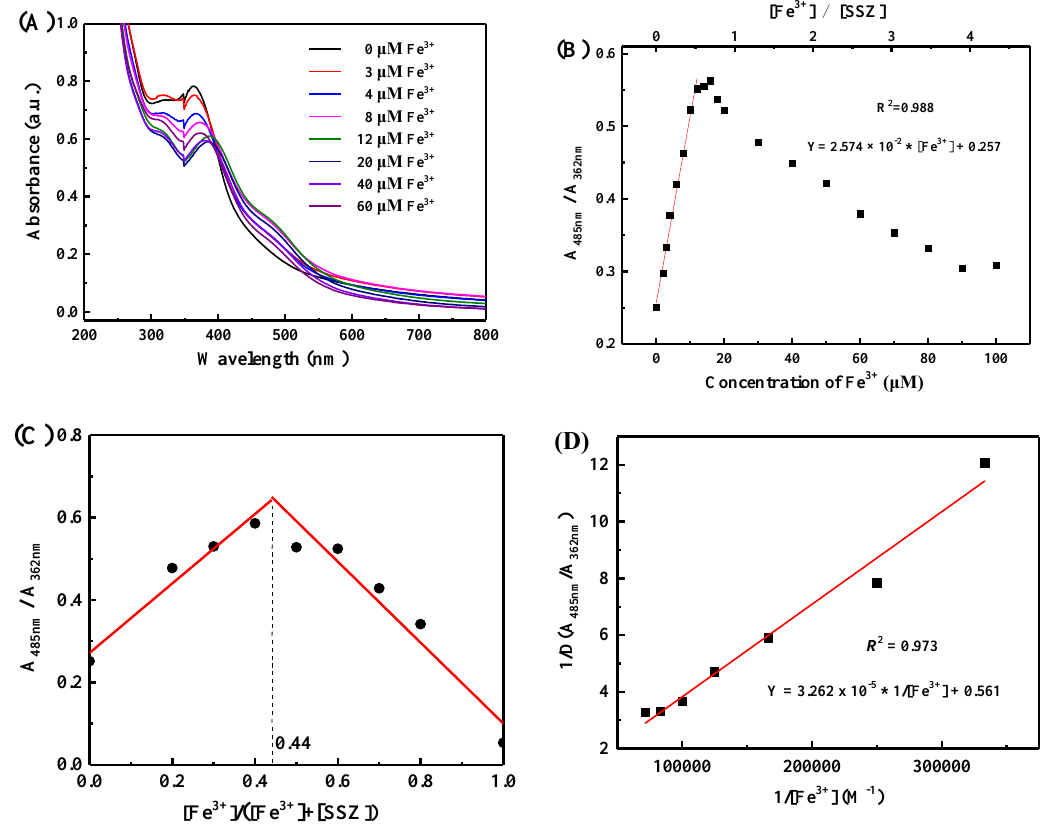
Figure 4. ( A ) Representative UV-vis absorption spectra of SSZ-MG aqueous suspensions with the presence of various concentrations of Fe 3 + ions at 25 ◦ C and pH of 5.6. The concentration of SSZ-MG aqueous suspensions was 0.174 mg / mL. The corresponding concentration of SSZ moieties ([SSZ]) in SSZ-MG aqueous suspensions was 23.09 µ M. ( B ) A 485 nm / A 362 nm ratio as a function of Fe 3 + concentration ([Fe 3 + ]) as well as [Fe 3 + ] / [SSZ] ratio. ( C ) Job’s plot of SSZ-MGs and Fe 3 + . The total concentration ([SSZ] + [Fe 3 + ]) of SSZ moieties in SSZ-MGs and Fe 3 + ions was kept constant to be 20 µ M. ( D ) Modified Benesi–Hilderbrand plot of SSZ-MGs with Fe 3 + in the [Fe 3 + ] concentration range of 3–14 µ M.